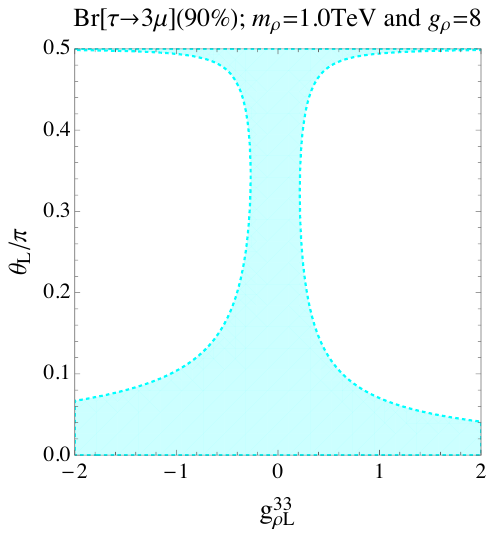
Figure 1 . The (cid:28) ! 3 (cid:22) decay constraint on the plane ( g 33 90% C.L. upper limit on the branching ratio has been taken from eq. (3.21). The shaded region is allowed at the 90% C.L. read off from eq. (3.21).